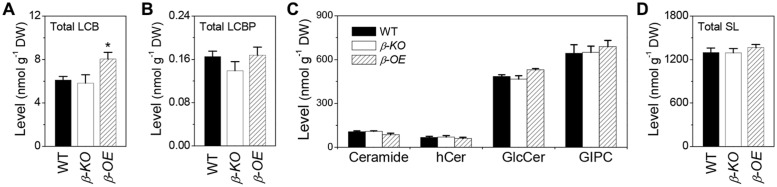
Levels of total LCBs, total LCBPs, and total complex sphingolipids in pPLAIIIβ-knockout and overexpression plant leaves. (A) The level of total LCBs, summarized from individual species in Figure 2B. (B) The level of total LCBPs, summarized from individual species in Figure 2C. (C) The levels of total complex sphingolipids, including Cer, hCer, GlcCer, and GIPC, summarized from individual species in Figures 3–6. (D) The total content of sphingolipids (SL), including free sphingolipids, such as LCBs and LCBPs, and complex sphingolipids, such as Cer, hCer, GlcCer, and GIPC. β-KO, T-DNA knockout of pPLAIIIβ (Salk_057212). β-OE, overexpression mutant of pPLAIIIβ driven by cauliflower mosaic 35S promoter. Values are means ± SE (n = 5). *Significant difference at P < 0.05 compared with the WT, based on Student’s t-test.